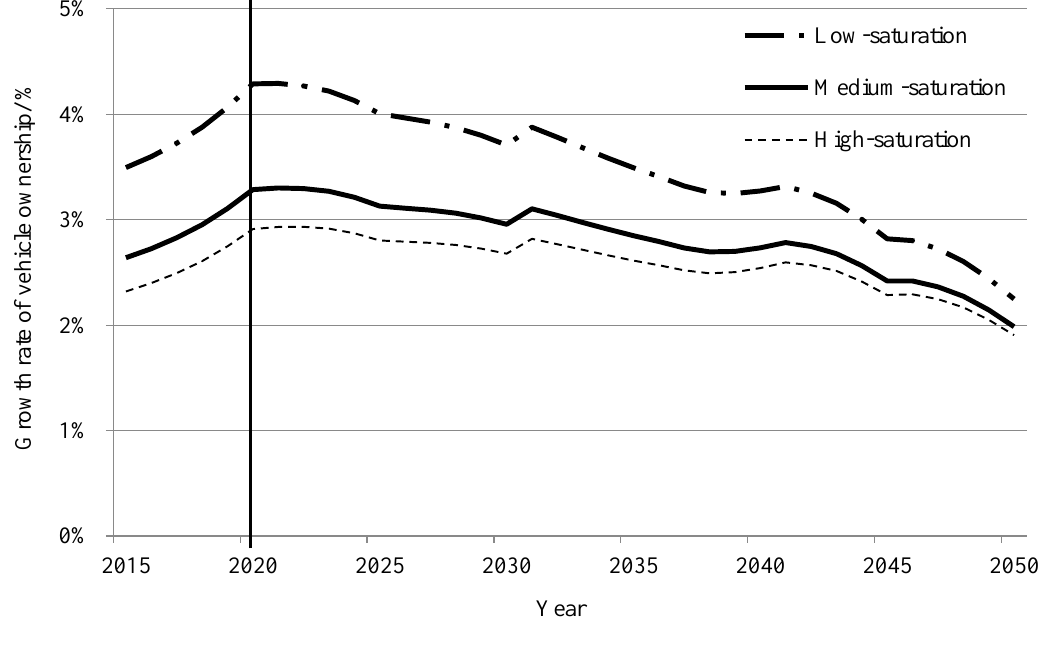
Figure 11. Sensitivity analysis of vehicle saturation level on vehicle ownership: Growth